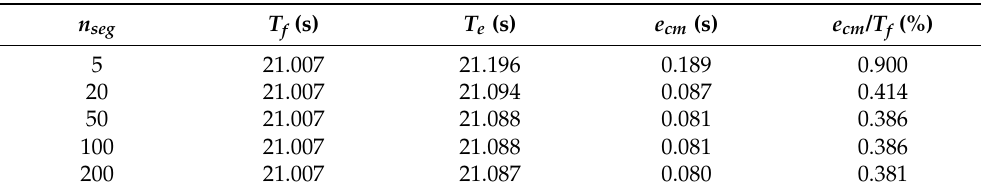
Table 2. Simulation results under different n seg .